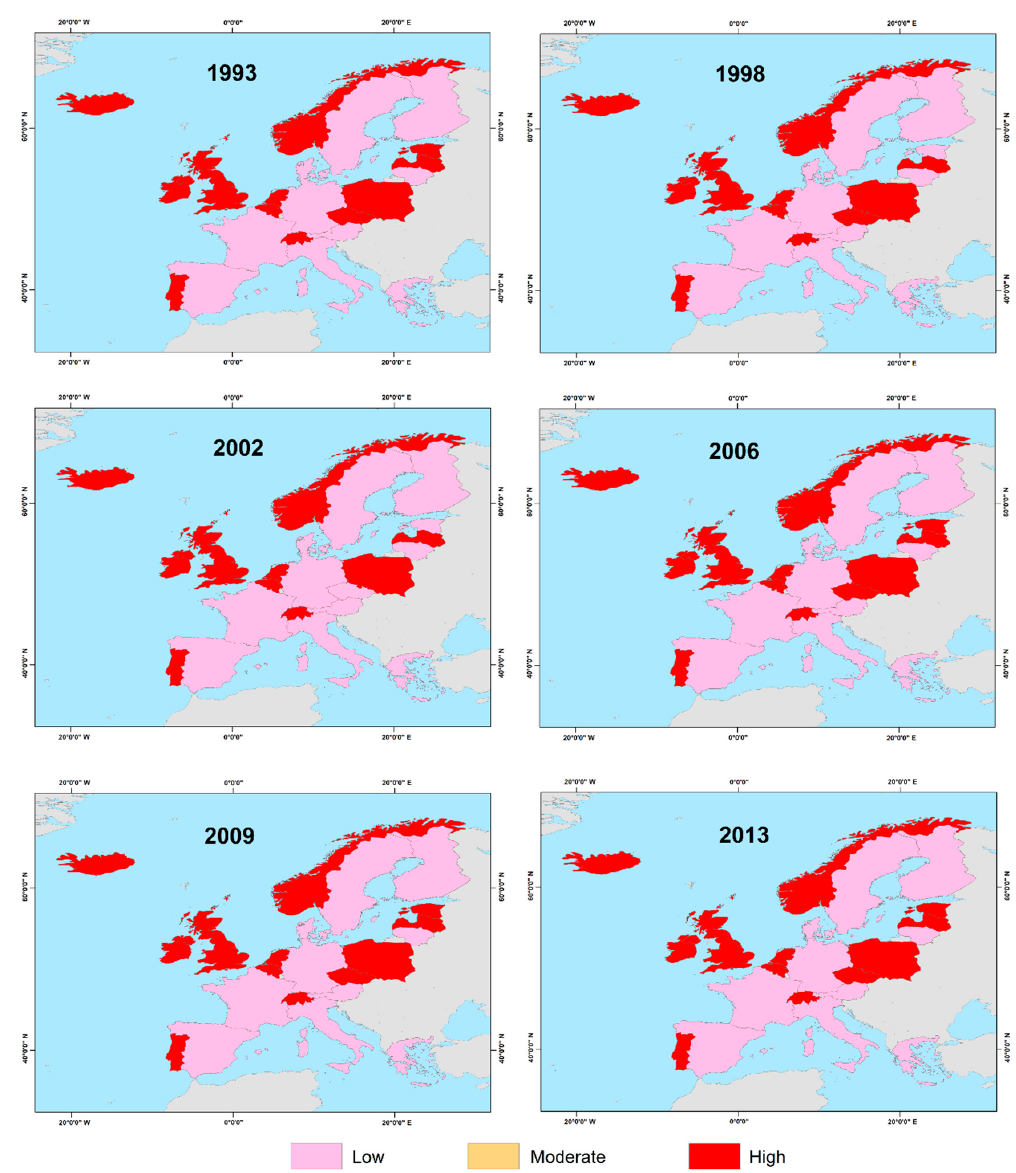
Figure 5. Infant mortality (parameter θ ) for female gender in 1993, 1998, 2002, 2006, 2009, and 2013.